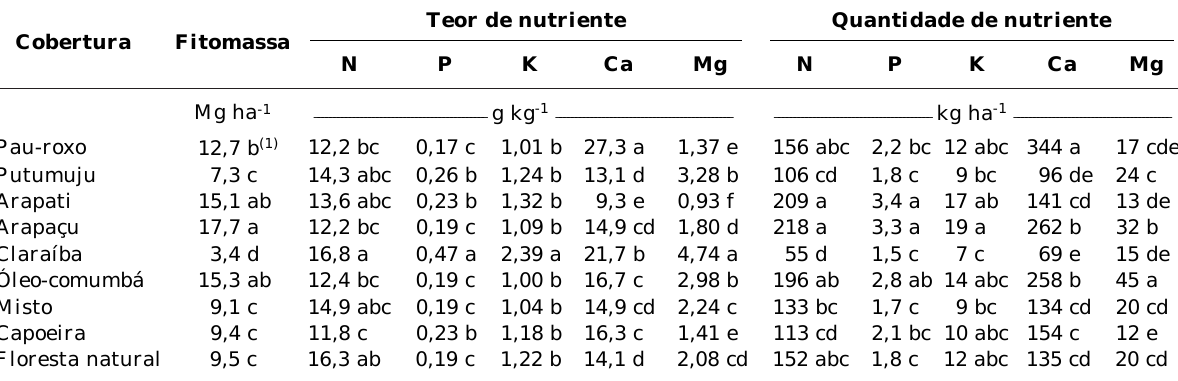
Quadro 1. Fitomassa, teores e quantidades de nutrientes da serapilheira de diferentes coberturas florestais na região sudeste da